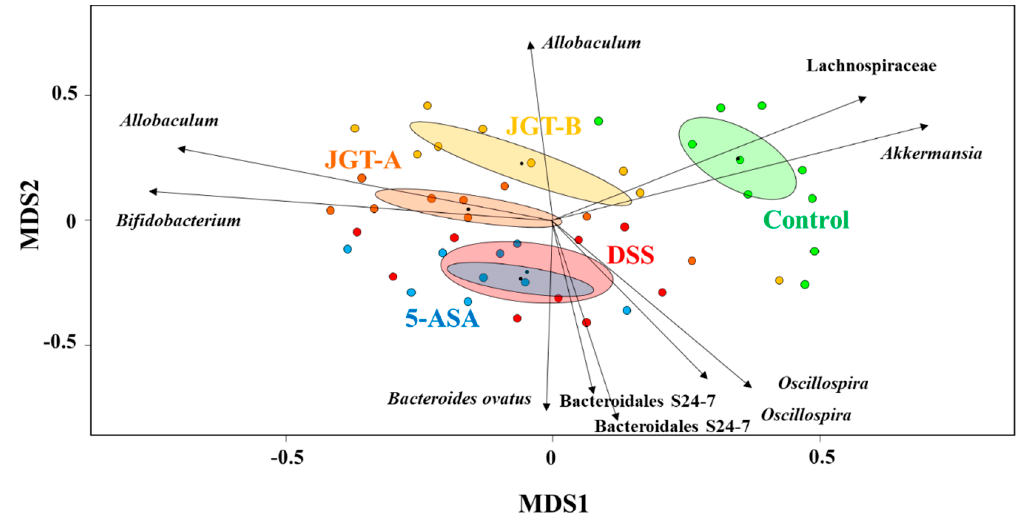
Figure 2. Biplot from a non-metric multidimensional scaling (NMDS) (stress value = 0.299, R 2 = 0.64) with 48 sample sites and species vectors. Ten most correlated operational taxonomic units (OTUs) were indicated with arrows representing the strength and direction of the correlation.